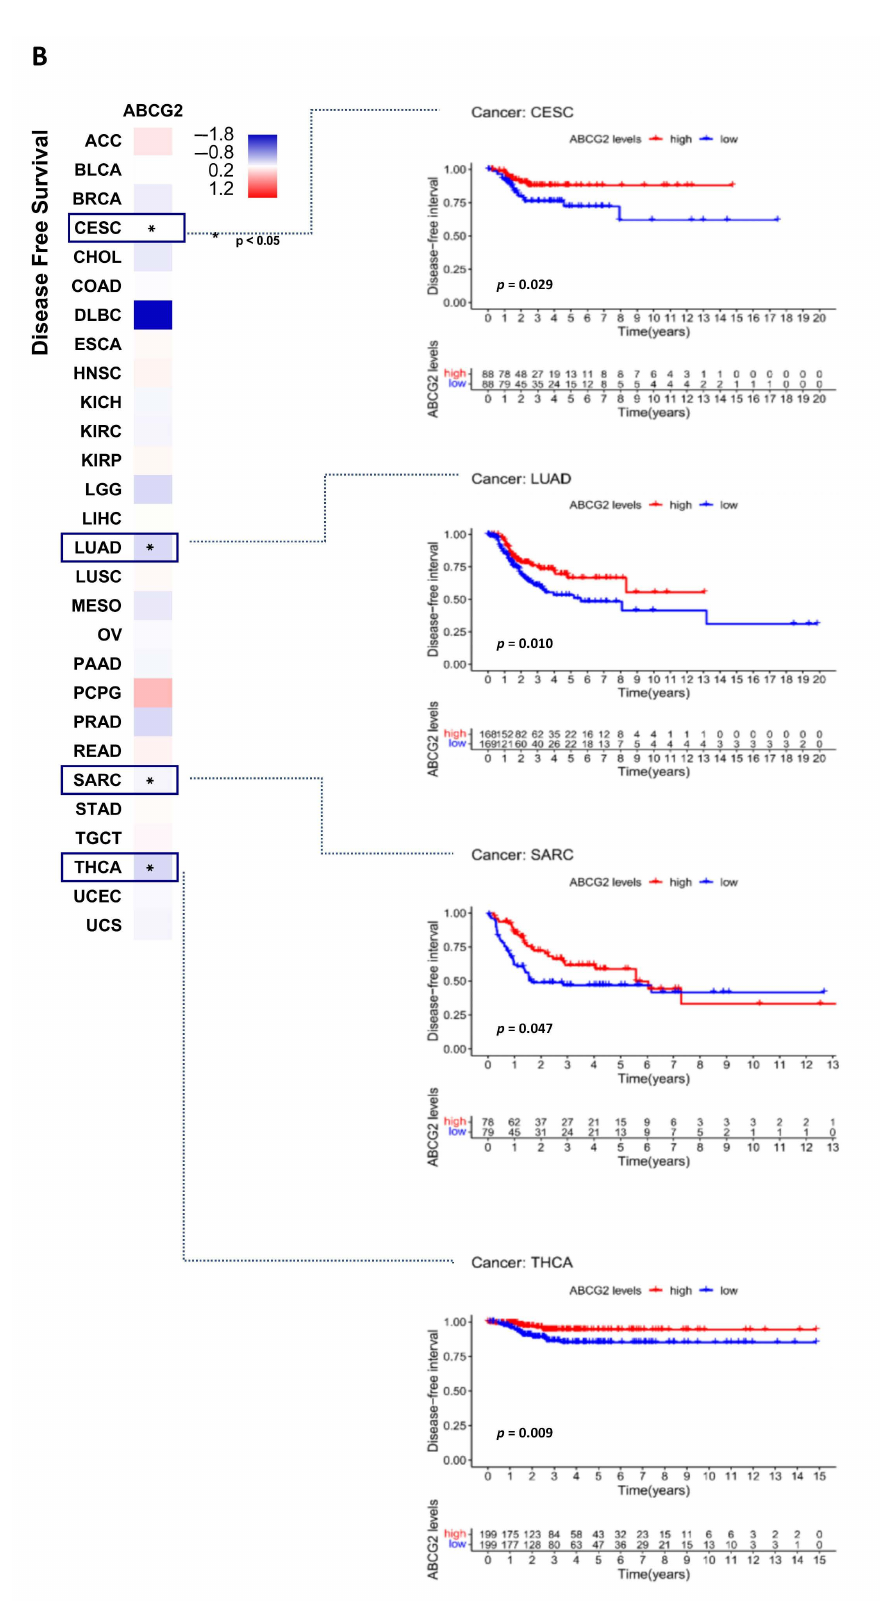
Figure 3. Correlation between ABCG2 gene expression, overall survival, and disease-free survival for different cancer types: ( A , B ) The pan-cancer survival maps with significant results are given. For the Kaplan–Meier survival analysis, patients were grouped into high and low ABCG2 expression scores determined by the comparison with the median by log-rank